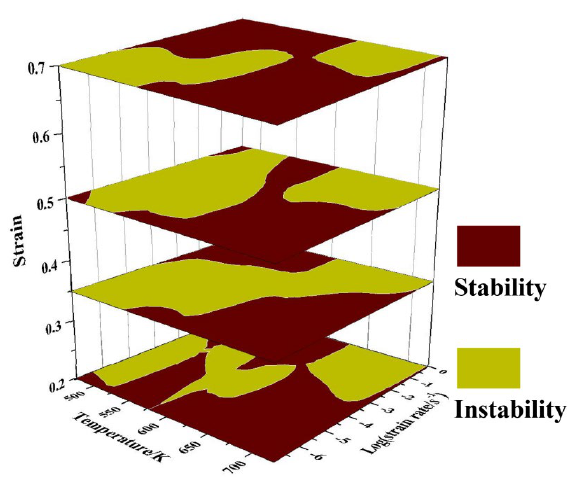
Figure 8. The 3D maps of the flow instability diagram of the Mg − 2Sn − 1Ca alloy at various strains.